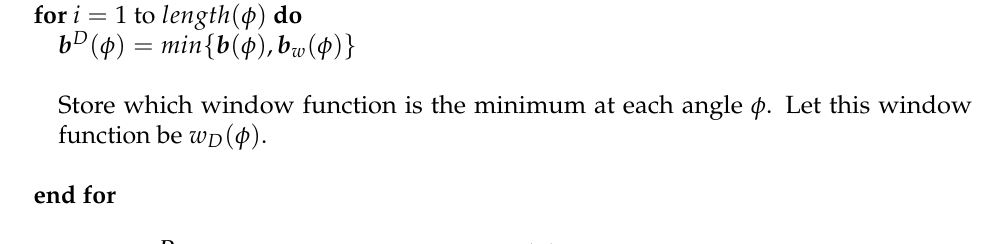
Figure 4. Bartlett spectra versus DOA for a uniform linear array of 15 elements in the presence of two signals incident at 60 ◦ (25 dB SNR) and 85 ◦ (0 dB SNR), dual apodization (Chebyshev and uniform windows applied). Algorithm 1 Mixed Windowed Bartlett Spectra